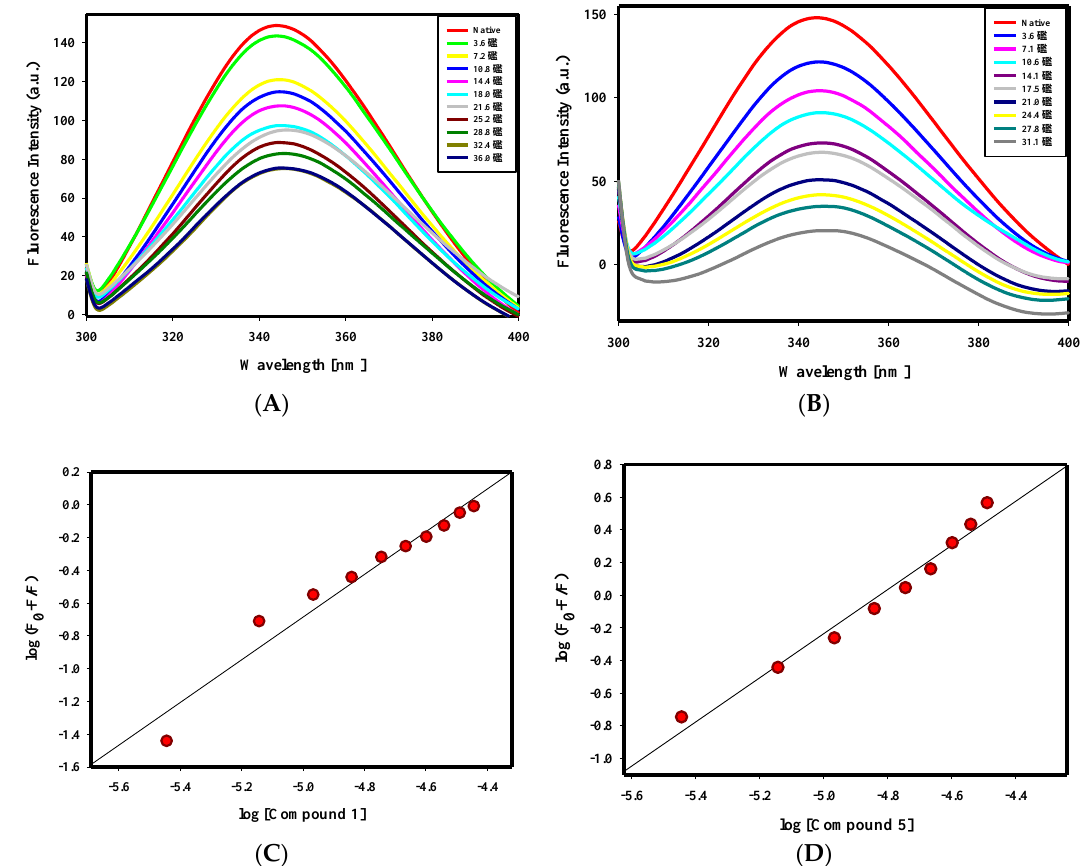
Figure 4. Binding studies of Compounds 1 and 5 with SphK1. Fluorescence emission spectra of SphK1 with increasing concentrations of ( A ) compound 1 (0–36 μM) and ( B ) compound 5 (0–31.1 μM). SphK1 was excited at 280 nm, and emission spectra were recorded in the range of 300–400 nm. Modified Stern–Volmer plot showing quenching of SphK1 fluorescence with increasing concentration of ( C ) Compound 1 and ( D ) Compound 5 .